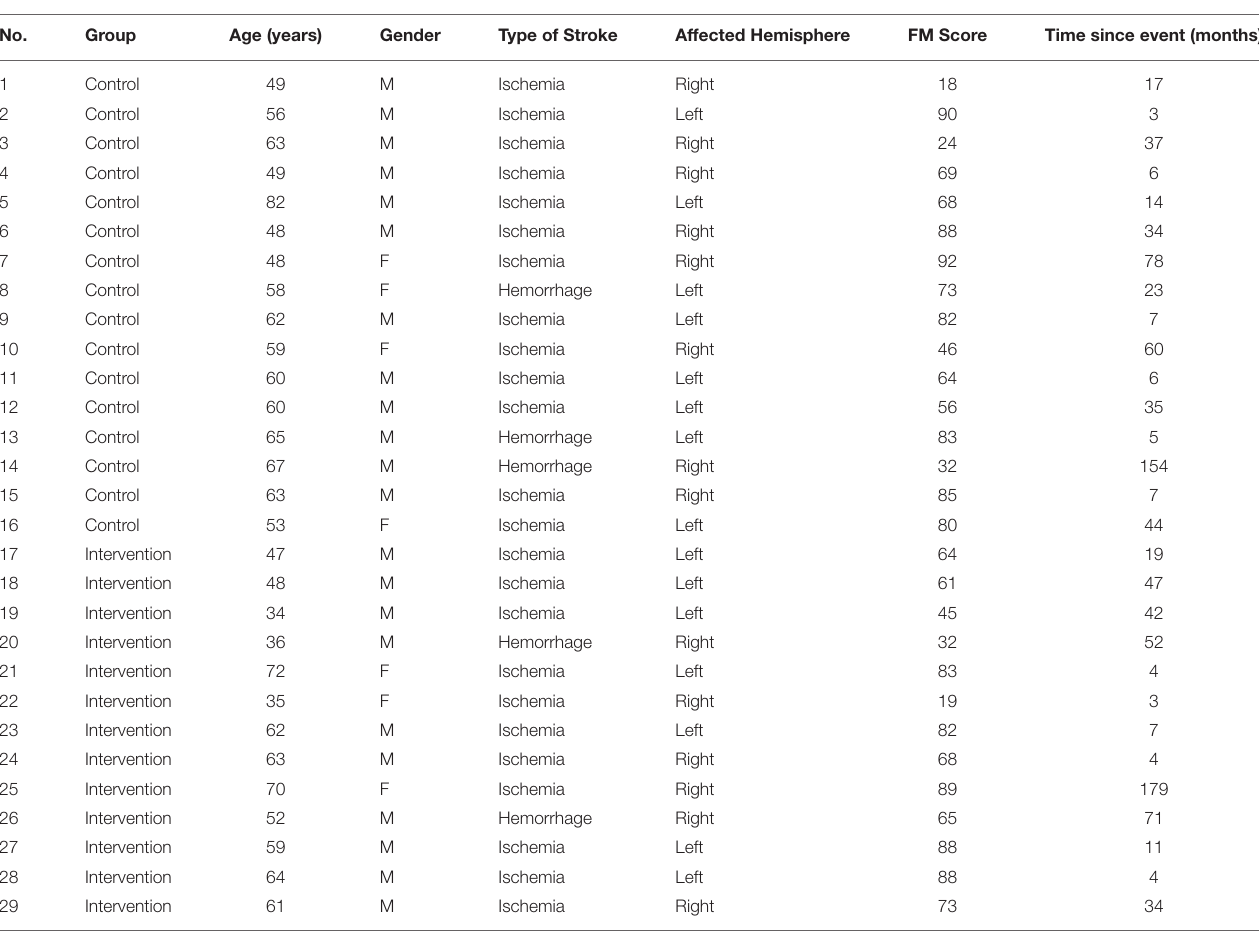
TABLE 1 | Patients’